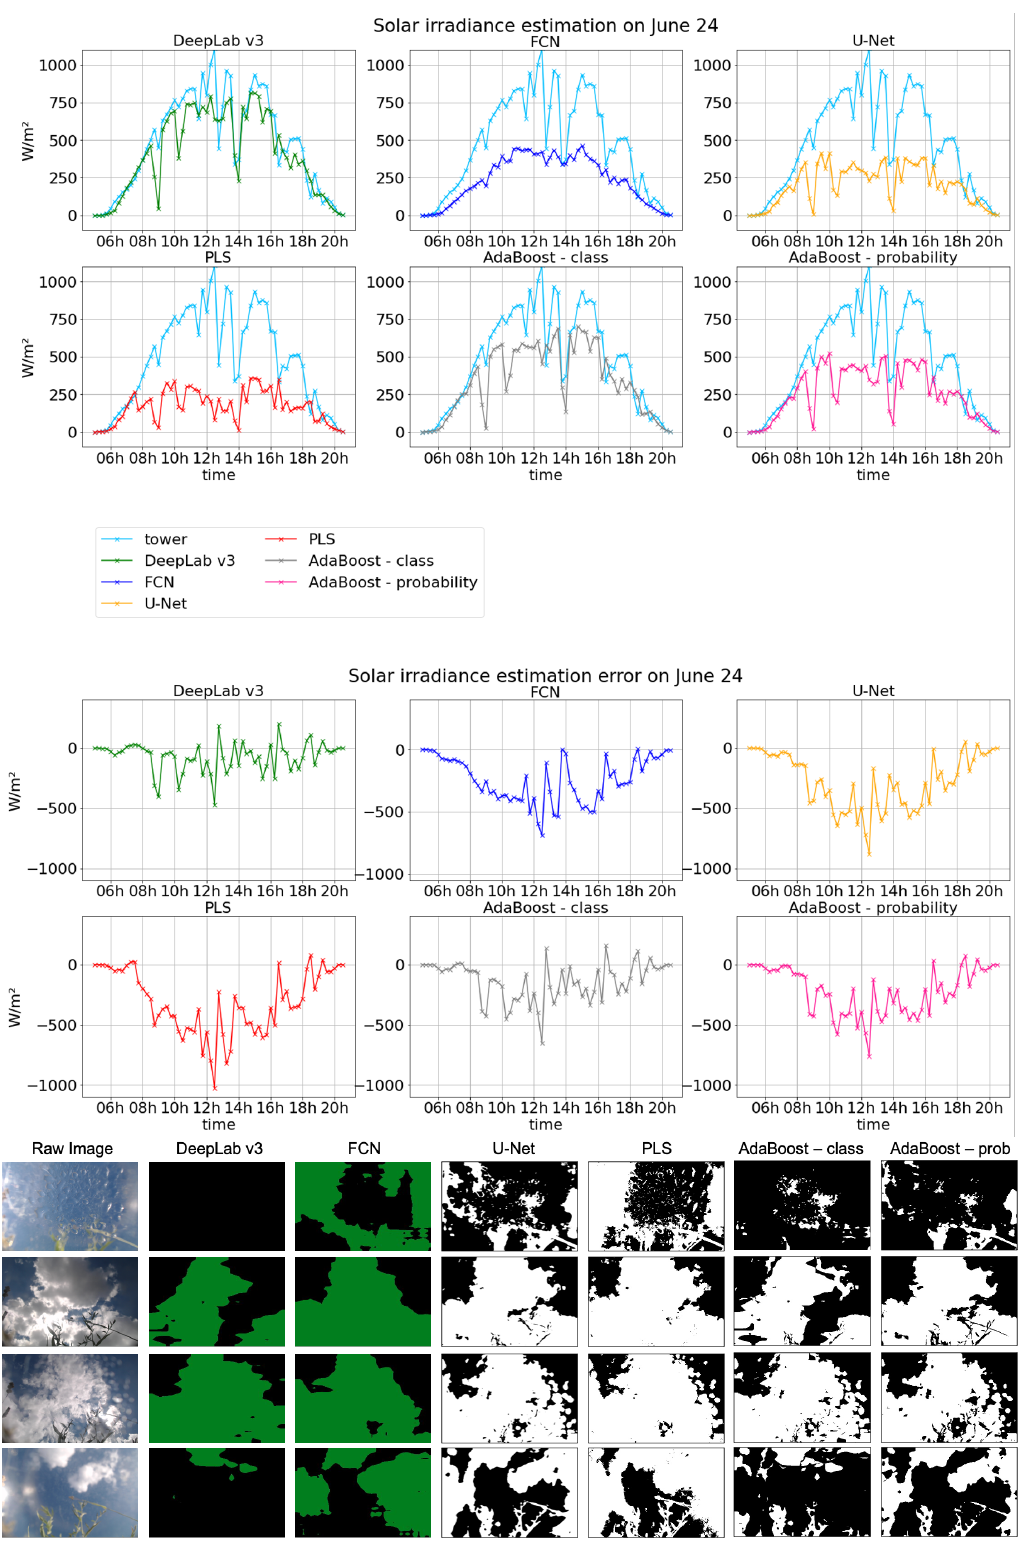
Figure A6. Solar irradiance estimation result based on cloud cover estimation from each machine learning model